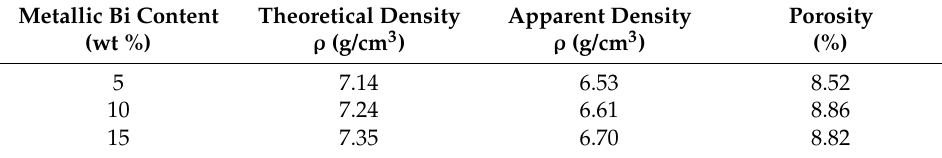
Table 1. Density, porosity of the LaFe 11.6 Si 1.4 H y /Bi composites with different metallic Bi contents.